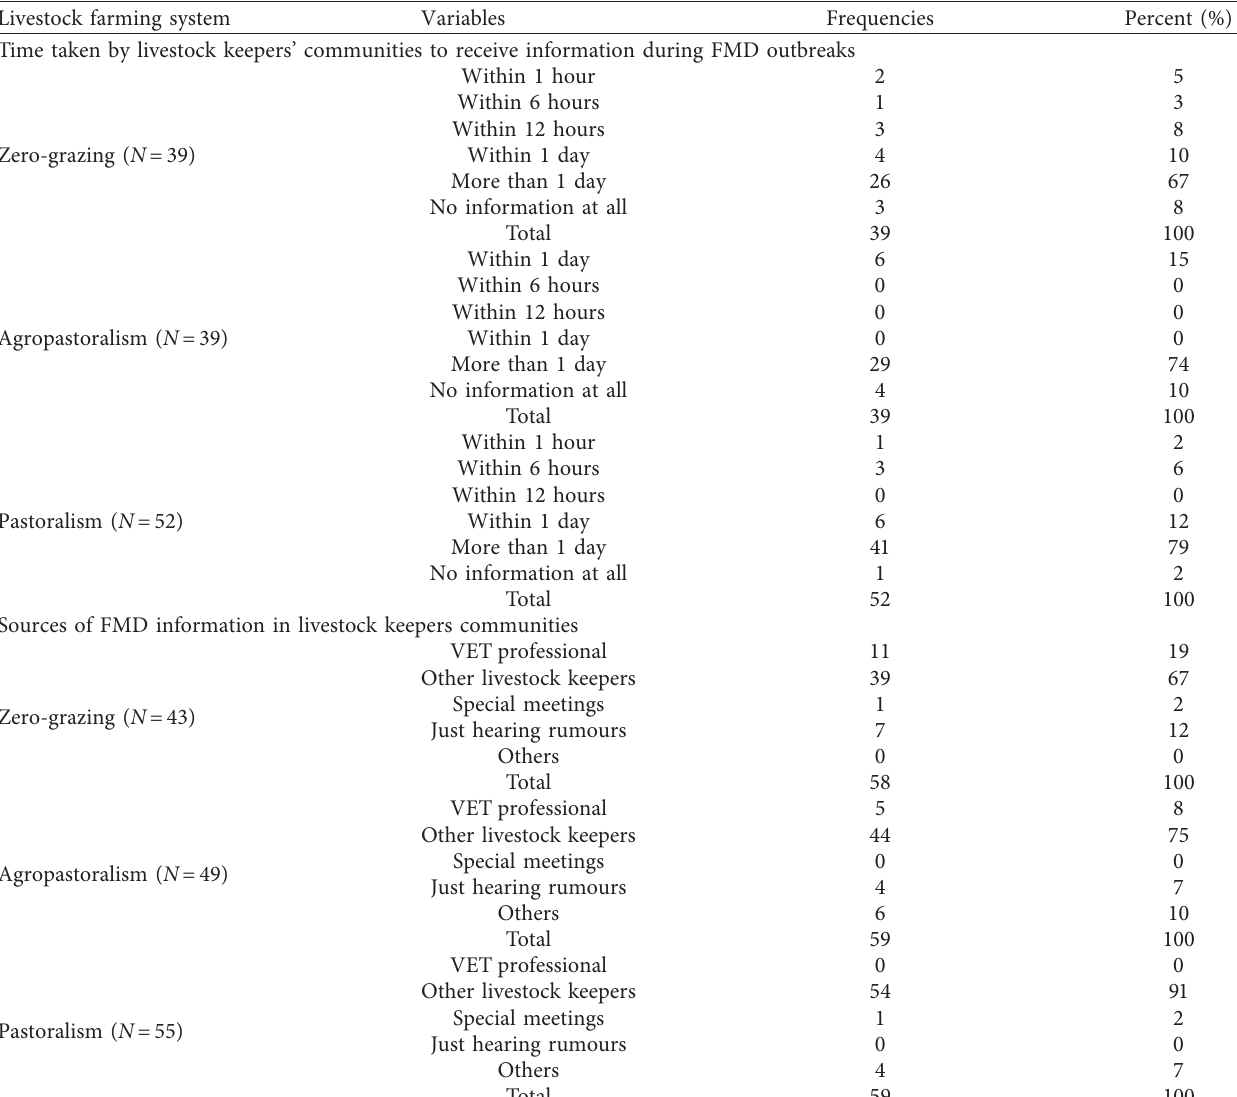
Table 3: Time taken by livestock keepers to receive FMD outbreaks information from different sources and sources of FMD information. Livestock farming system Variables Frequencies Time taken by livestock keepers’ communities to receive information during FMD outbreaks